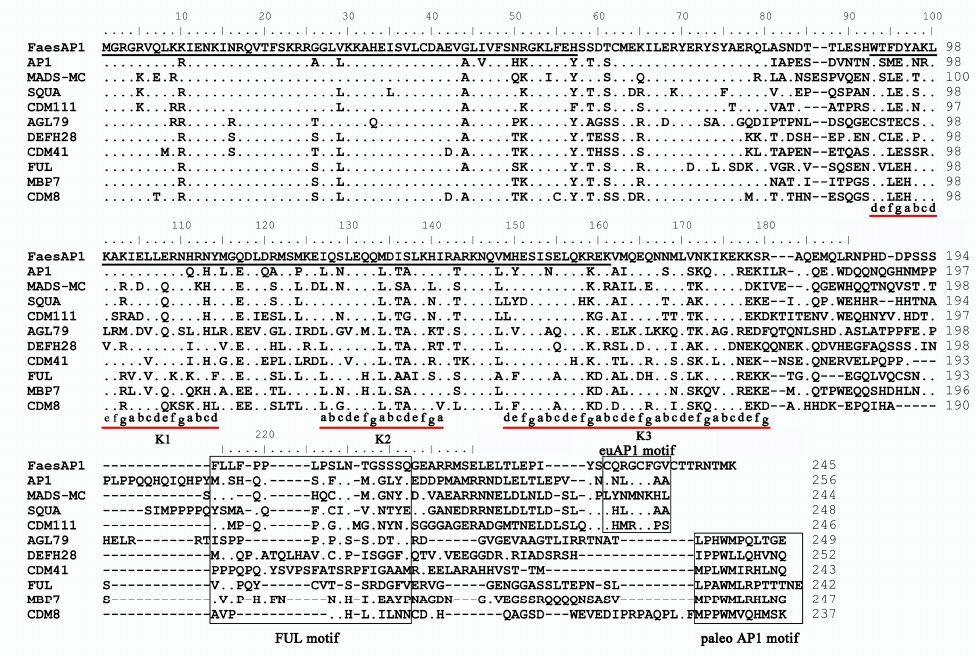
Figure 3. Sequence alignments of FaesAP1 with AP1 / FUL-like proteins from model plants. The first underlined region indicates the MADS domain and the second the K domain. The relatively conserved FUL motif, euAP1 motif and paleoAP1 motif located in the various C-terminal region are boxed. Amino acid residues identical to FaesAP1 are indicated as dots. Dashes introduced into the sequence in order to improve the alignment. The k1, k2 and k3 subdomains with (abcdefg)n repeats that usually contain hydrophobic amino acids at positions a and d are underlined